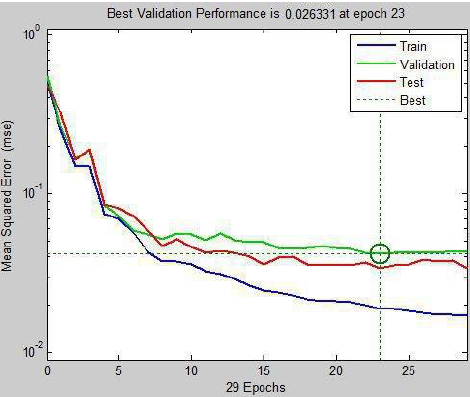
Figure 9. The regression diagrams achieved by the designed neural network.